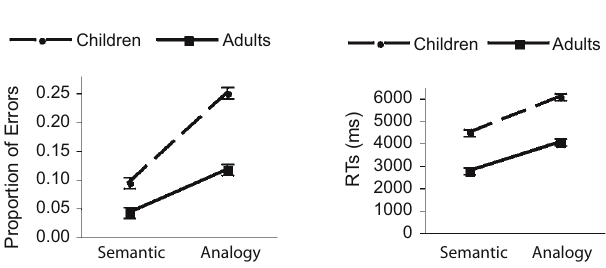
Figure 2. Behavioral results for performance during fMRI data